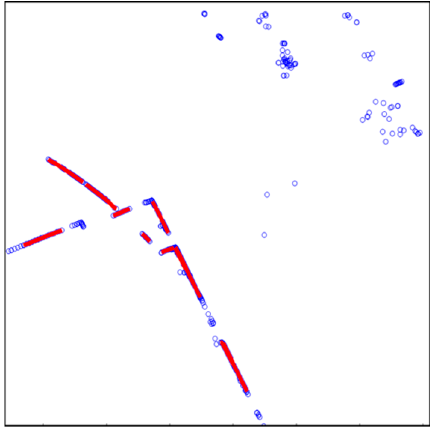
Figure 10. Result of vertical structure line extraction.